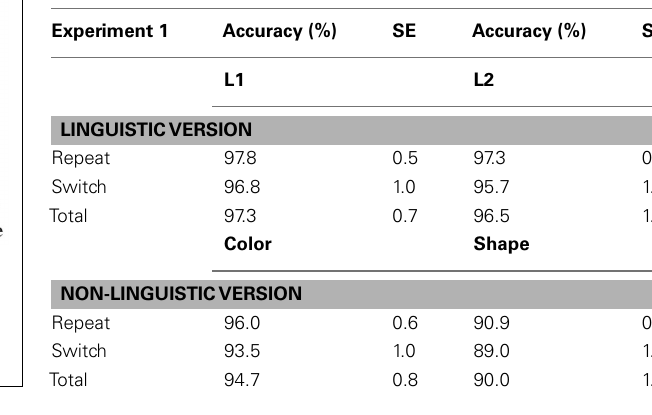
Table 2 |Accuracy (%) and SE in the linguistic and non-linguistic versions of the task-switching broken for trial types for the Experiment